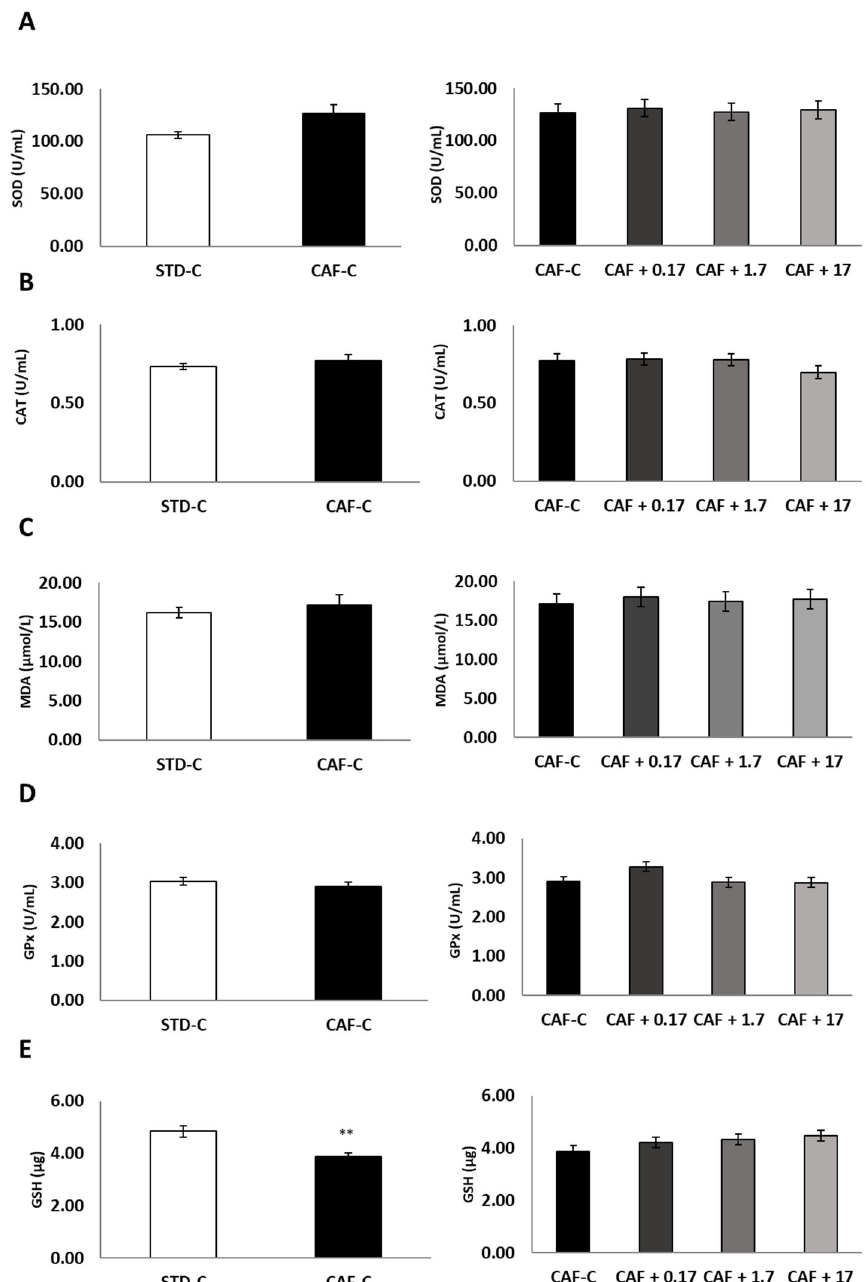
Figure 1. Hepatic SOD ( A ), CAT ( B ), MDA ( C ), GPx ( D ) and GSH ( E ) levels. All values are means ± standard error of the mean (SEM). Differences between rats fed standard (STD) diet and supplemented with vehicle (STD-C, n = 10) and rats fed cafeteria (CAF) diet and supplemented with vehicle (CAF ‐ C, n = 10) were assessed by using Student’s t parametric test ( t test) for independent samples: **, significantly different compared to the STD ‐ C group ( p < 0.01). CAT, catalase; GPx, glutathione peroxidase; GSH, glutathione; MDA, malondialdehyde; SOD, superoxide dismutase.